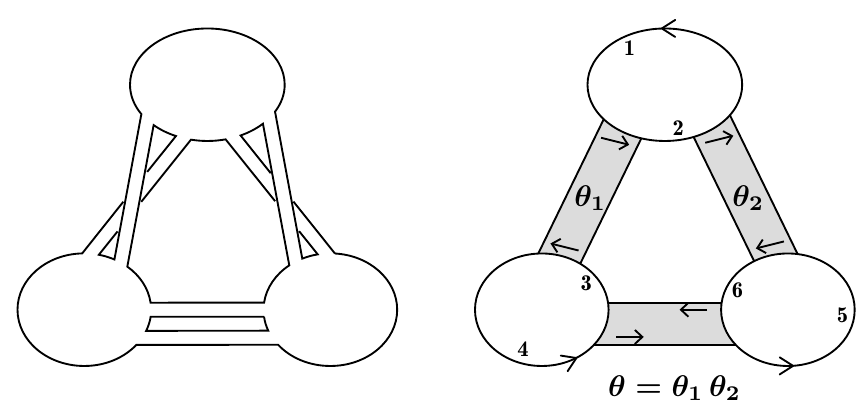
Figure 22 . (Left) Original Feynman graph, (Right) Skeleton-reduced graph with (cid:22) (cid:11) = (12)(34)(56) and V = (13)(25)(46). The two face permutations of the skeleton graph are (cid:23) = (145)(263) which neglects the internal Wick-contractions, and (cid:22) ! = (12)(3456) which remembers the internal structure through (cid:18) =